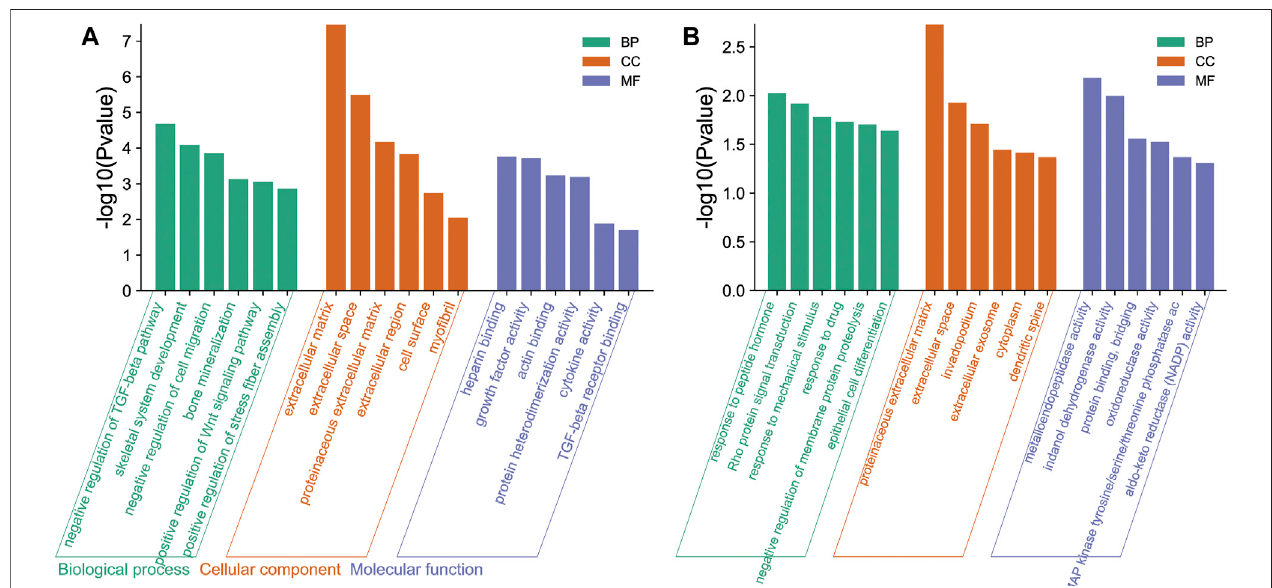
FIGURE3| GeneOntology(GO)functionalenrichmentofdifferentiallyexpressedgenes(DEGs)inosteogenicandadipogenicdifferentiationofhumanbonemarrow mesenchymal stem cells (hMSCs). These genes were enriched in various biological process (BP), cellular component (CC), and molecular function (MF) terms. The ordinateisindicatedona − log10( p -value)scale. (A) Themainenrichmentresultsoftheupregulatedgenes. (B) Themainenrichmentresultsofthedownregulatedgenes.